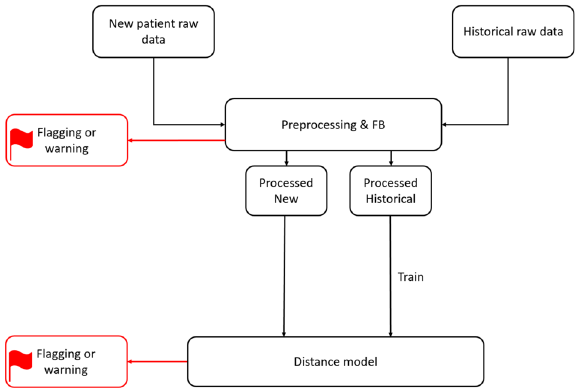
Fig. 3 Model schematic. The fl ow of data through the pipeline is illustrated as well as the different pipeline components and the different places where fl agging or warnings may